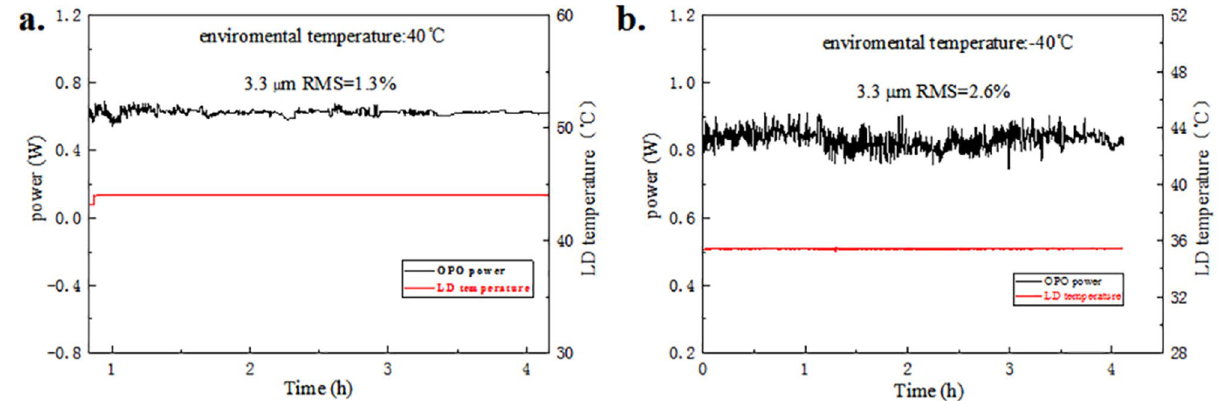
Figure 8. Results of test at low and high temperatures. ( a ) Shows the result at high temperature; ( b ) Shows the result at low temperature. (Origin 2018, https ://www.origi nlab.com/, Adobe Photoshop CC 2018, https ://www. adobe .com/cn/produ cts/photo